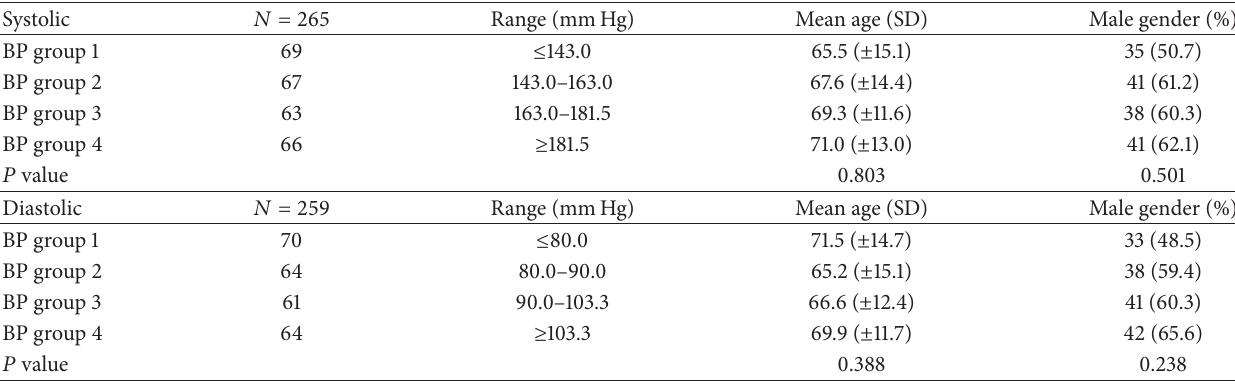
Figure 2: NIHSS at admission, NIHSS after tPA, and mRS after 3 months in the 4 systolic and diastolic blood pressure groups. A trend in poorer outcome is seen in patients with lowest and highest systolic and diastolic blood pressure. Outcome is represented with NIHSS at admission, after tPA and mRS after 3 months. Table 1: The blood pressure groups divided into